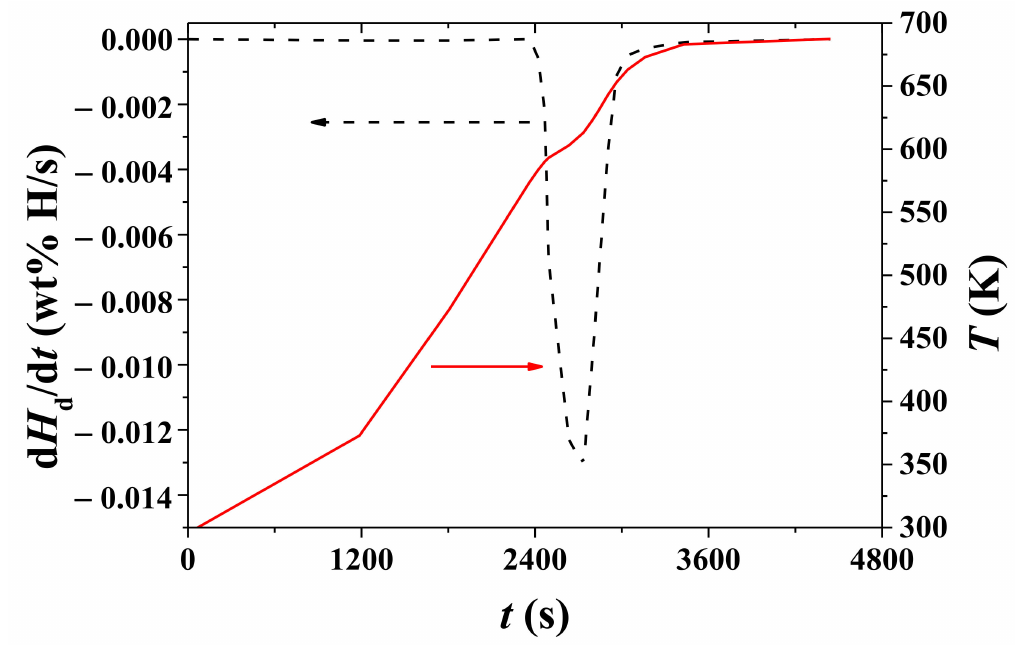
Figure 8. Variations with t of T and d H d /d t under 1.0 bar H 2 for hydrided Mg–5Ni. The sample was heated with a heating rate of 9